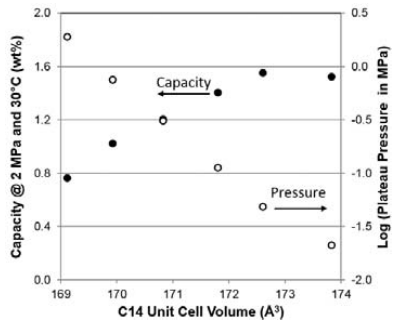
Figure 11. Plot of the H ‐ storage capacity and log (plateau pressure) vs. the C14 unit cell volume. Table 6. Summary of gaseous phase properties: maximum and reversible capacities, plateau pressure, slope factor, hysteresis, and changes in enthalpy and entropy.